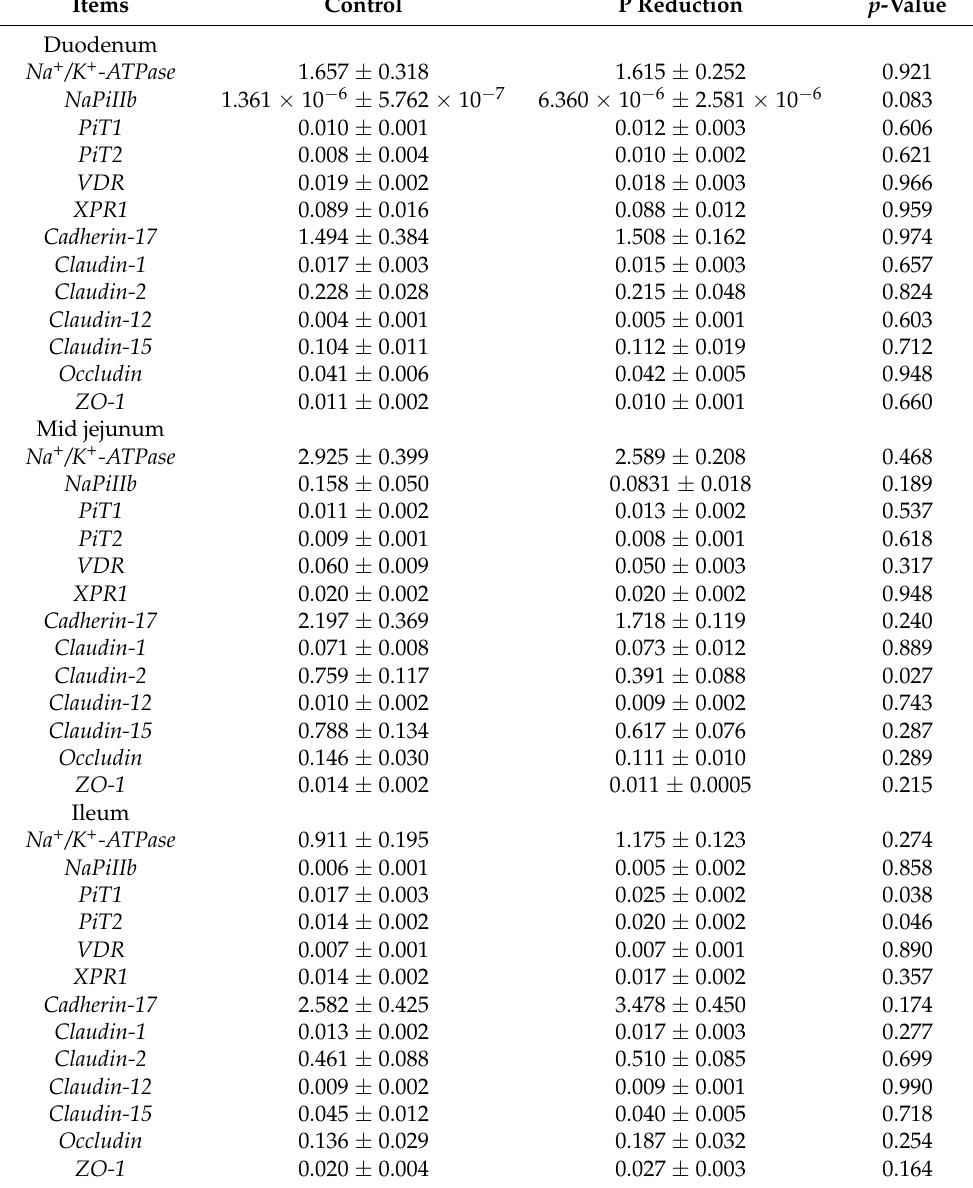
Table 7. Relative mRNA expressions of proteins in the duodenum, mid jejunum and ileum of young goats fed a low phosphorus (P) diet, normalised to 18S . (Mean values with their standard errors; n = 7